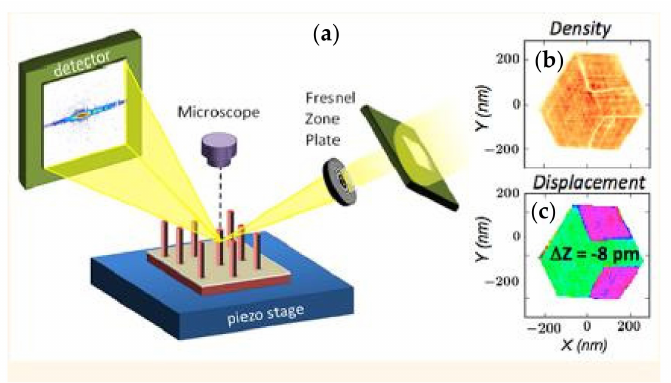
Figure 5. Principle of a 3D diffraction measurement at the mid-height of a GaN nanowire ( a ) images obtained at mid-height of the nanowire giving the density ( b ) and the component of the displacement field along the axis of the nanowire ( c ); the different colors indicate the presence of two inversion domains [80]. Reprinted from